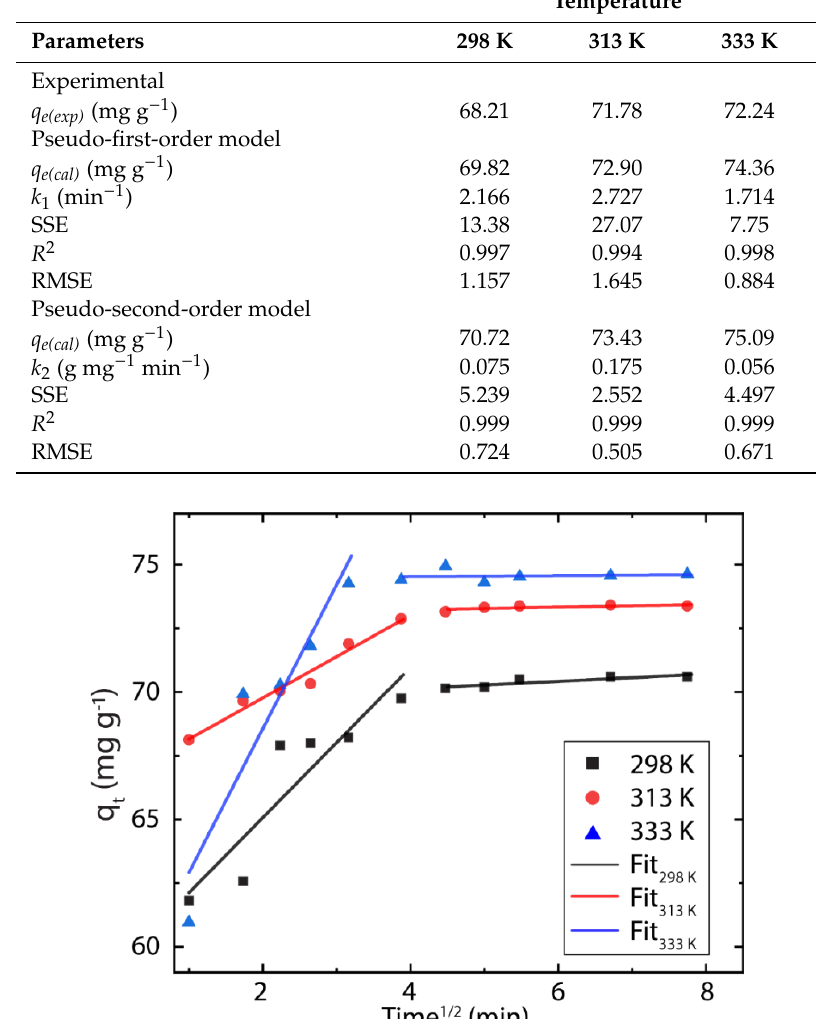
Figure 5. Intraparticle diffusion (IPD) plot showing two regions of linearity ( C 0 = 100 mg L − 1 , V = 250 mL, W = 500 mg) at different temperatures.